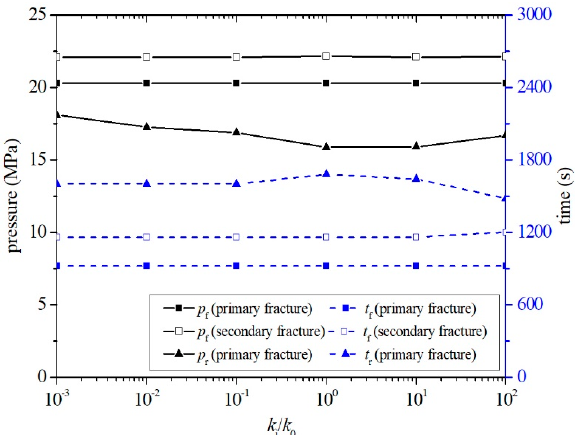
Figure 14. The breakdown pressure/time and reopening pressure/time of fractures in models with